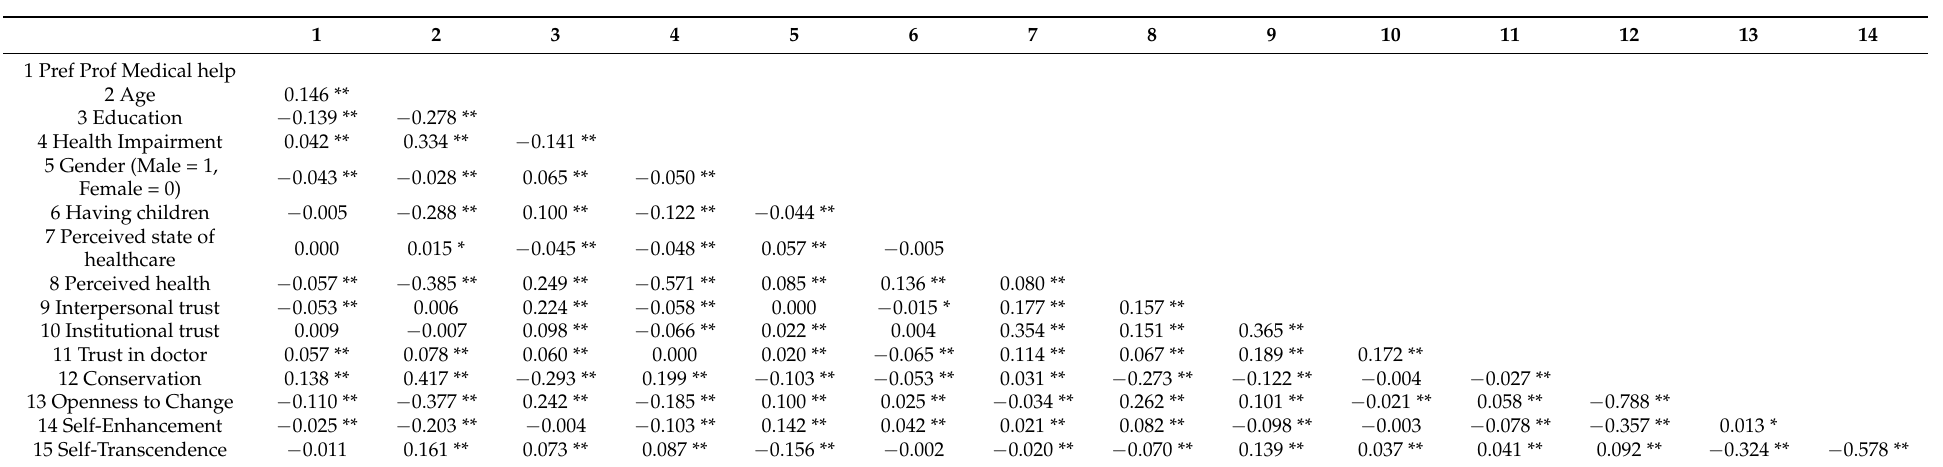
Table A1. Correlation Matrix of individual level factors of preference for professional medical